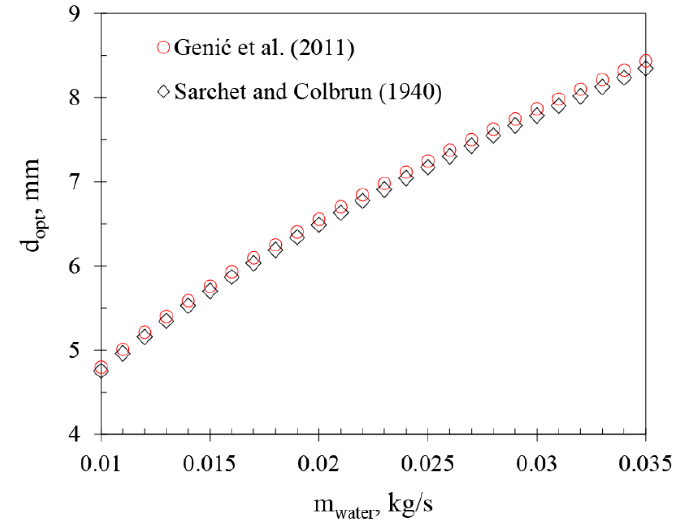
Figure 10. Change of economic optimum pipe diameter with water flow rate according to [51,52].